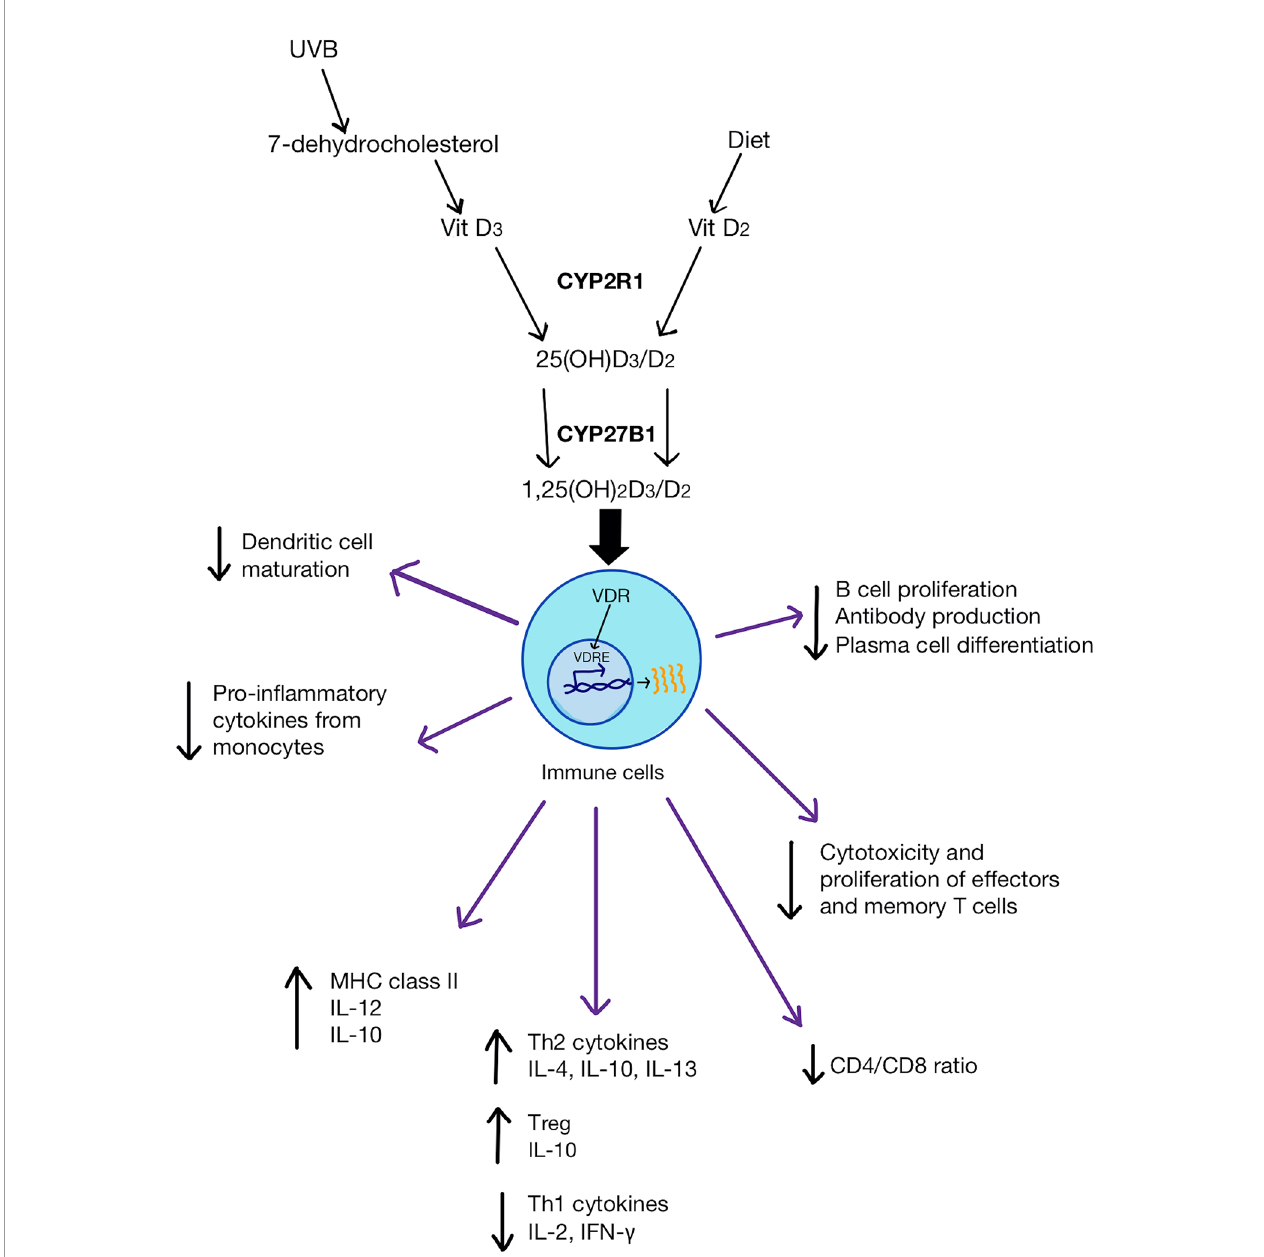
(OH)D 3 /D 2 into 1,25(OH) 2 D 3 /D 2 in the kidneys. 1,25(OH) 2 D binds to VDR in immune cells which then bind to VDRE on genes to changegeneexpression. 1,25(OH) 2 D can inhibit dendritic cell maturation, promote monocyte proliferation and differentiation into macrophages. It can also increase anti-in fl ammatory cytokines and the frequency of T regs , as well as reduce pro-in fl ammatory Th1 cytokines. 1,25(OH) 2 D can also reduce the ratio of CD4/CD8 and inhibit pro-in fl ammatory T cell differentiation and suppress antibody production by B